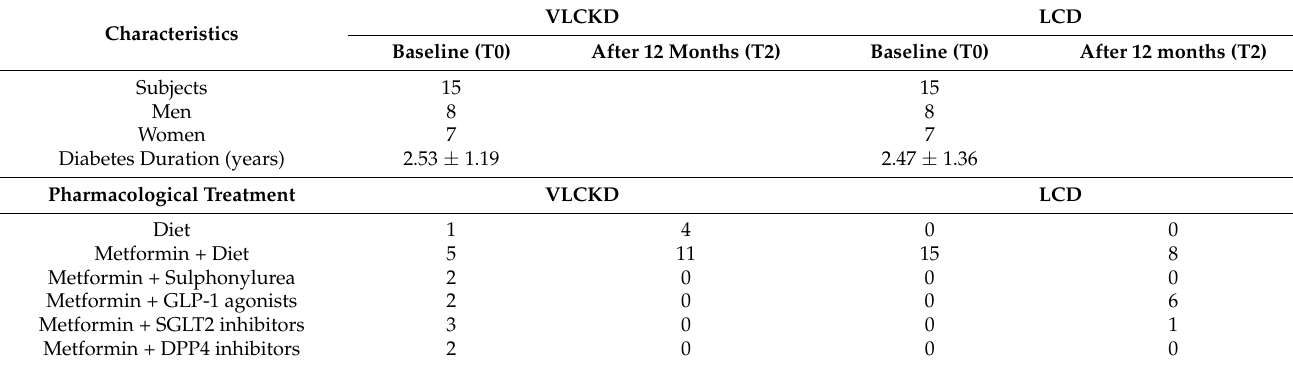
Table 2. Characteristics and pharmacological treatment at baseline and after 12 months in VLCKD and LCD groups.